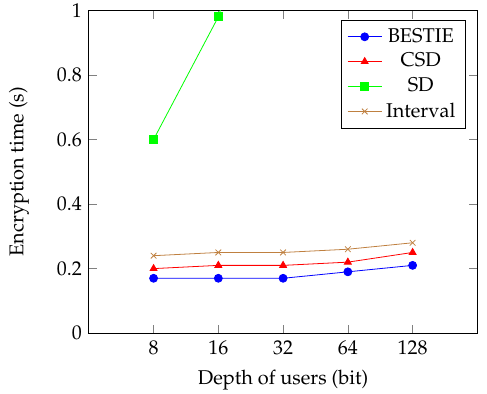
Figure 5. Encryption time in the BESTIE, CSD, SD, and interval schemes.